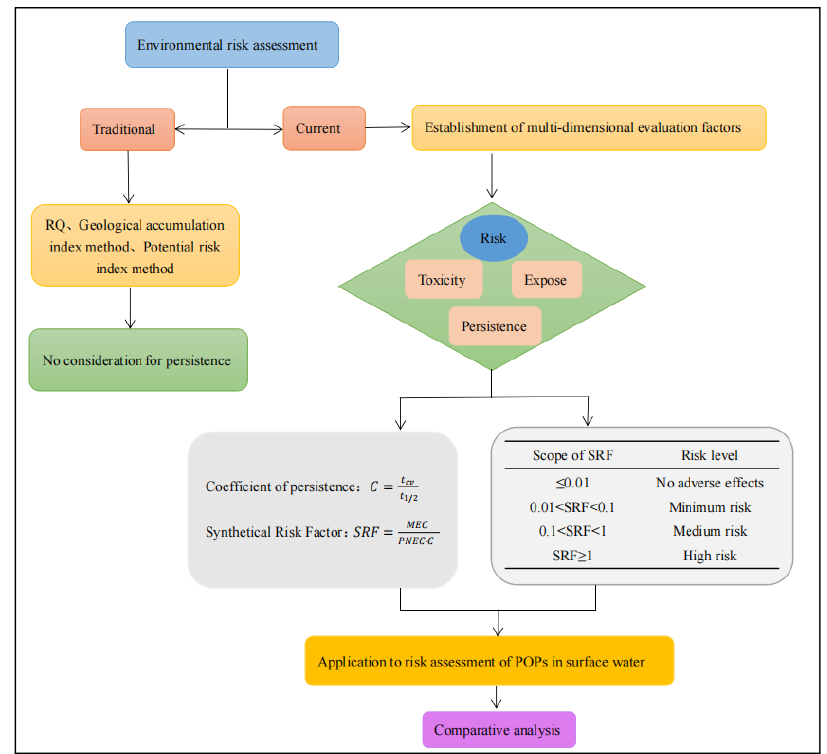
Figure 1. Flow diagram of analyzing environmental risks of pollutants based on multi-dimensional risk factors.